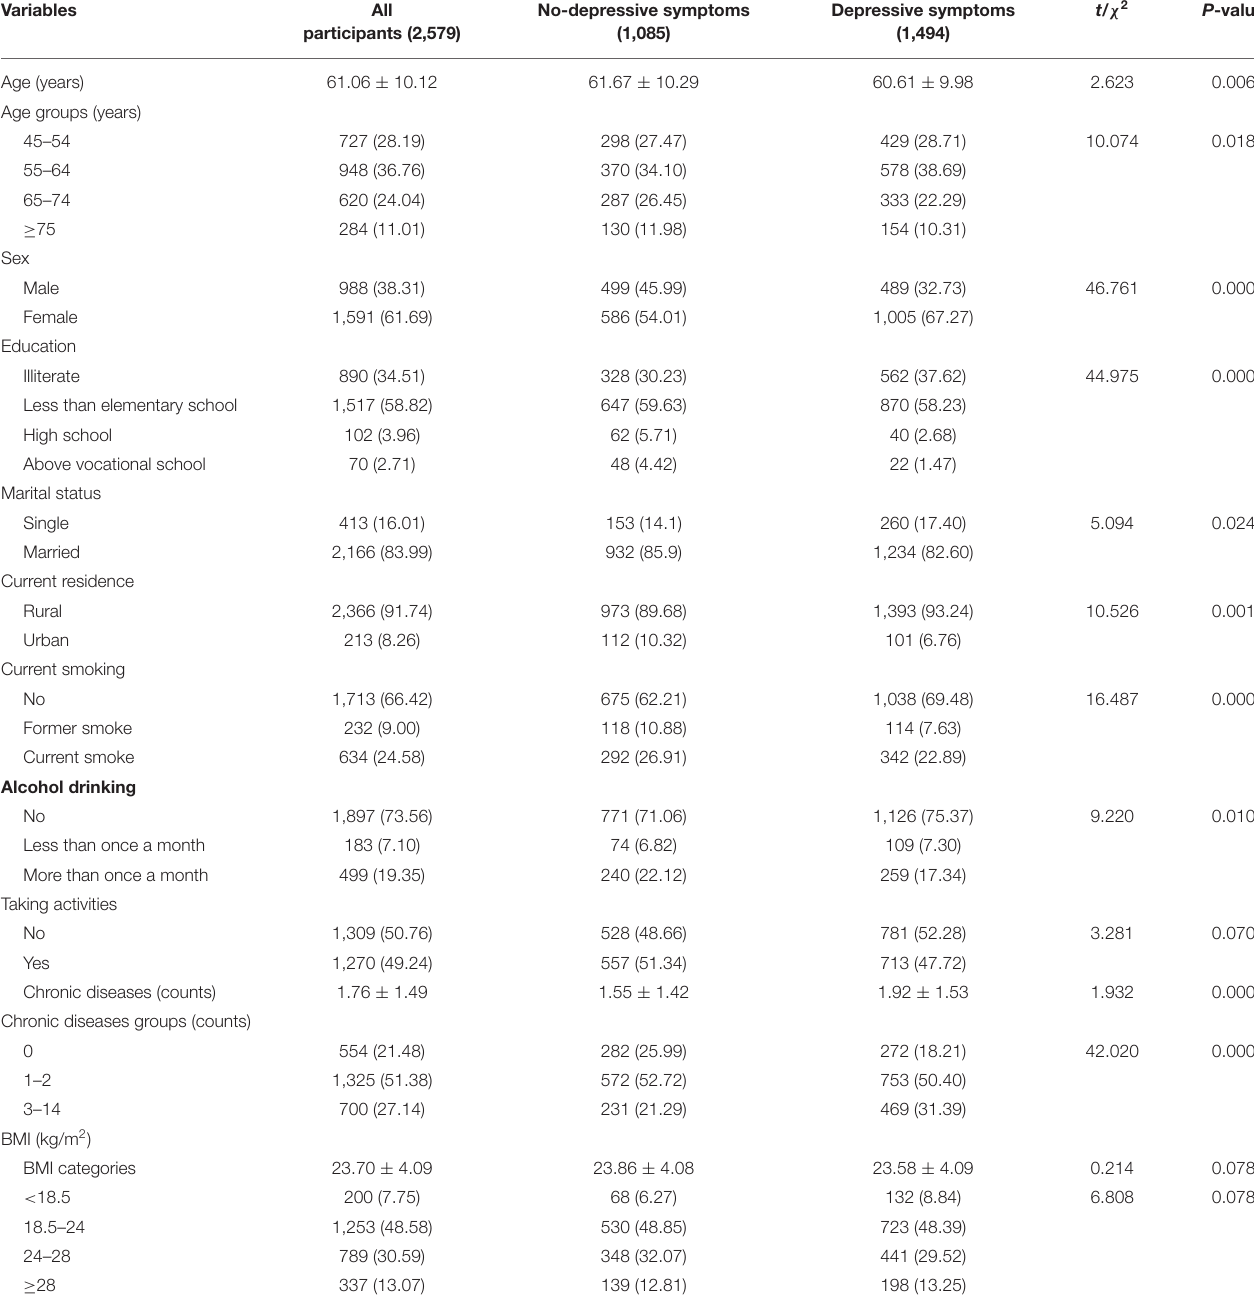
TABLE 1 | Baseline characteristics of participants according to the level of depressive symptoms in CHARLS Waves 2011 ( N, %).